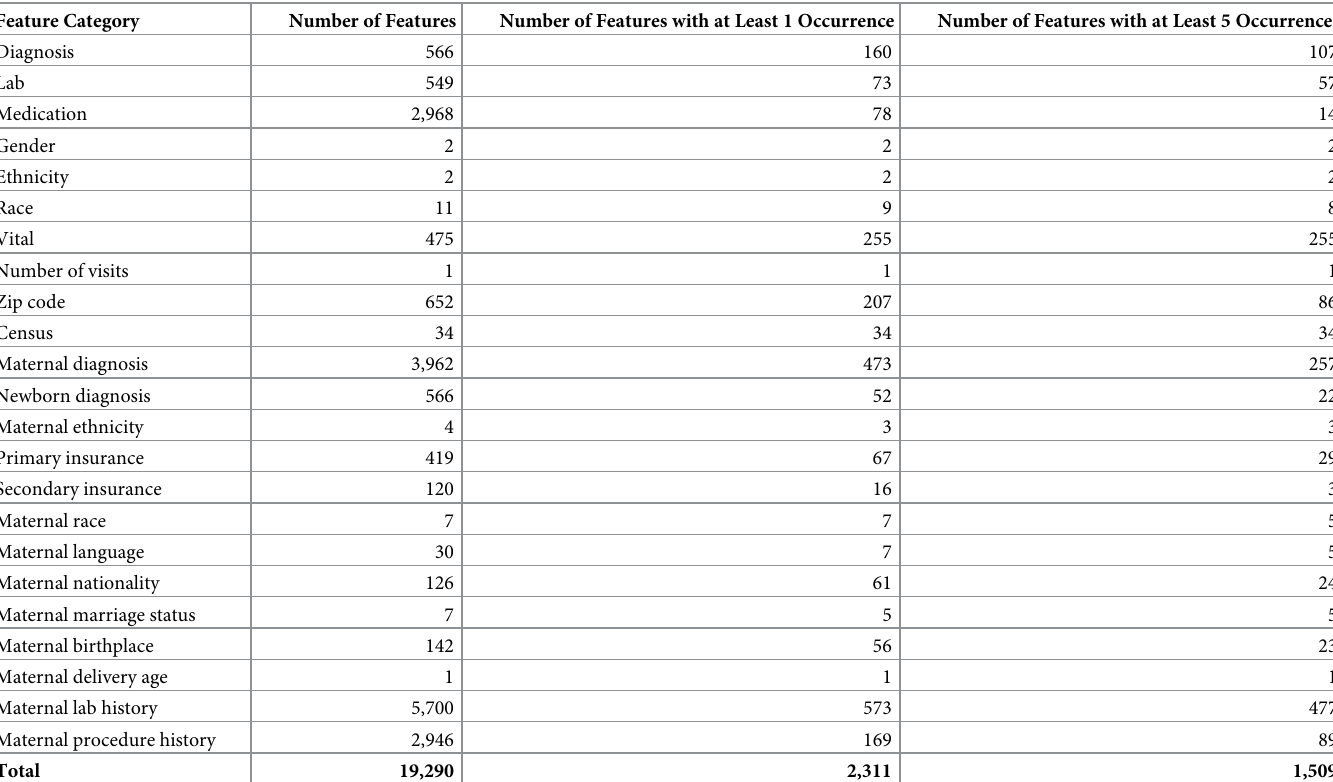
Table 2. Number of features by